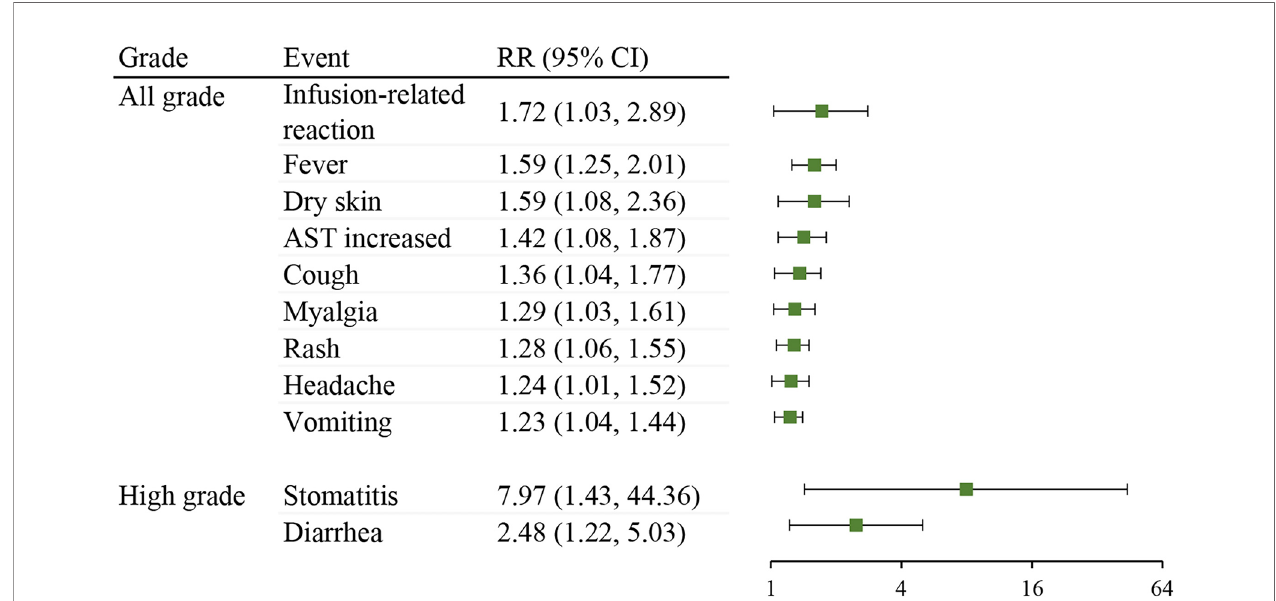
FIGURE 4 | Comparison of treatment-related adverse event types between neoadjuvant ICIs plus chemotherapy with neoadjuvant chemotherapy control arm in RCTs. RR, risk ratio; CI, con fi dence interval; AST, aspartate aminotransferase.